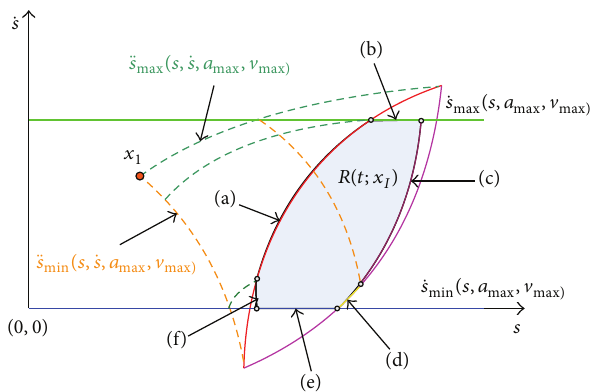
Figure 3: Reachable velocity sets from one initial